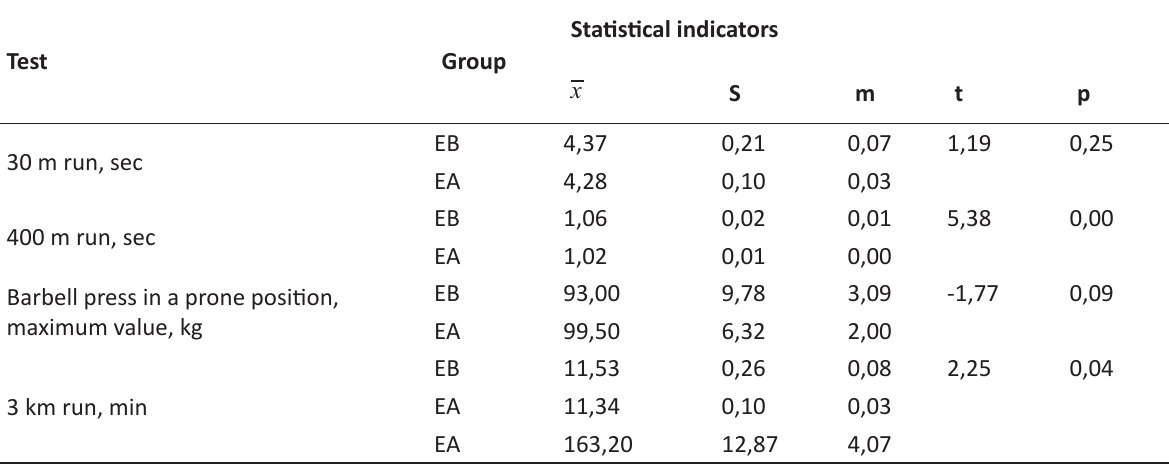
Table 2. The indicators of physical fitness of young rugby players of the experimental group before and after the experiment (n =